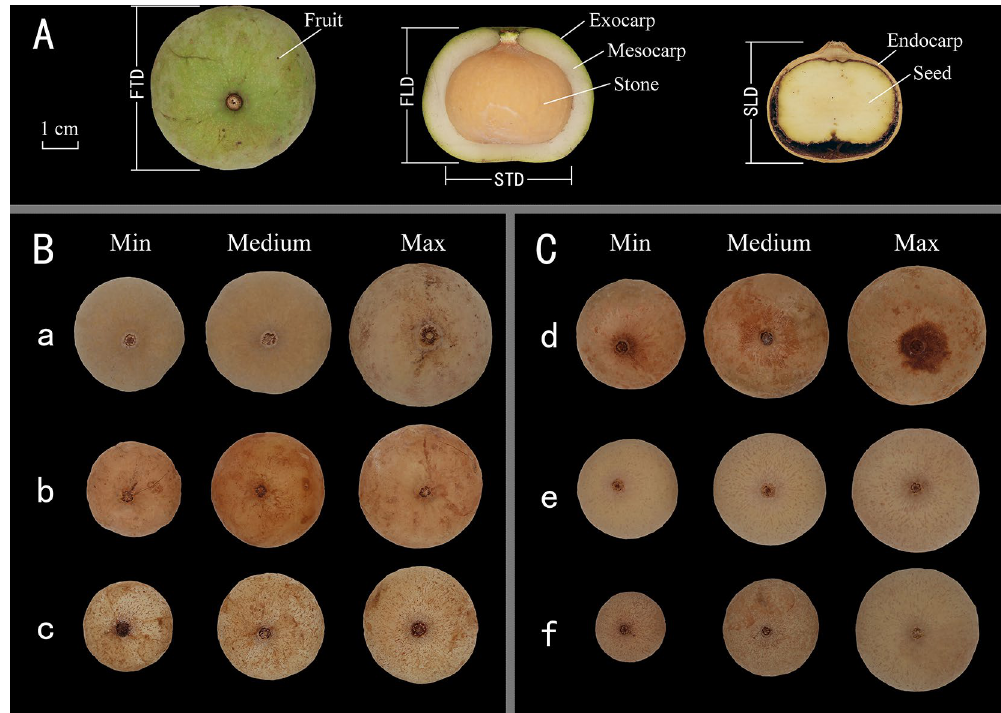
Figure 1. Fruit morphology of Malania oleifera . ( A ) Structure of fruit. ( B ) Stone size comparison of samples from Guangnan. ( C ) Stone size comparison of samples from Funing. (a) and (d): individuals with the largest average STD. (b) and (e): individuals with the medium average STD. (c) and (f): individuals with the smallest average STD. FTD fruit transverse diameter, FLD fruit longitudinal diameter, STD stone transverse diameter, SLD stone longitudinal